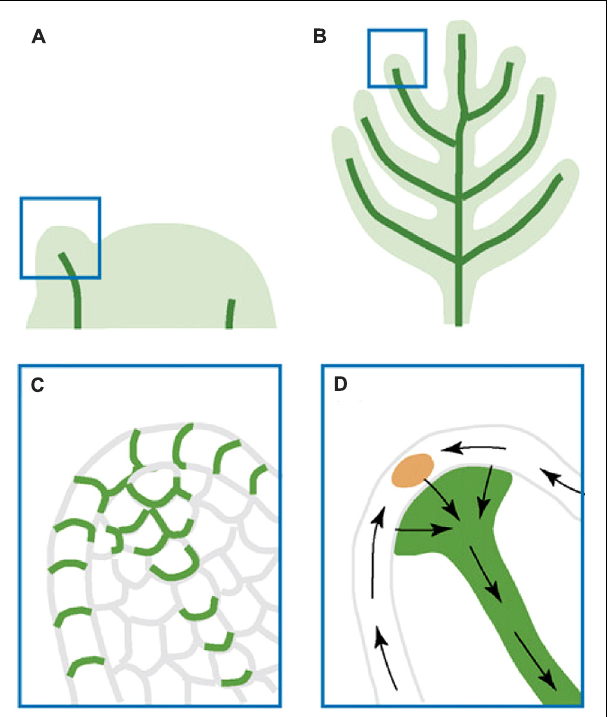
FIGURE 4 | Illustration of auxin transport during leaf and lateral organ initiation. (A) Leaf primordial initiation. (B) Lateral organ initiation. (C) A zoom-in diagram of the leaf primordium tip showing PIN:GFP (green) polar localization that indicates auxin transport routes. (D) Inferred auxin transport routes (black arrows) based on PIN:GFP localization.The epidermal convergence of two counter-oriented auxin flows results in a change of auxin transport direction toward the internal base of the primordium.This internal flow is responsible for the formation of the midvein.The figure is reproduced from Berleth etal. (2007) with permission from Copyright Clearance